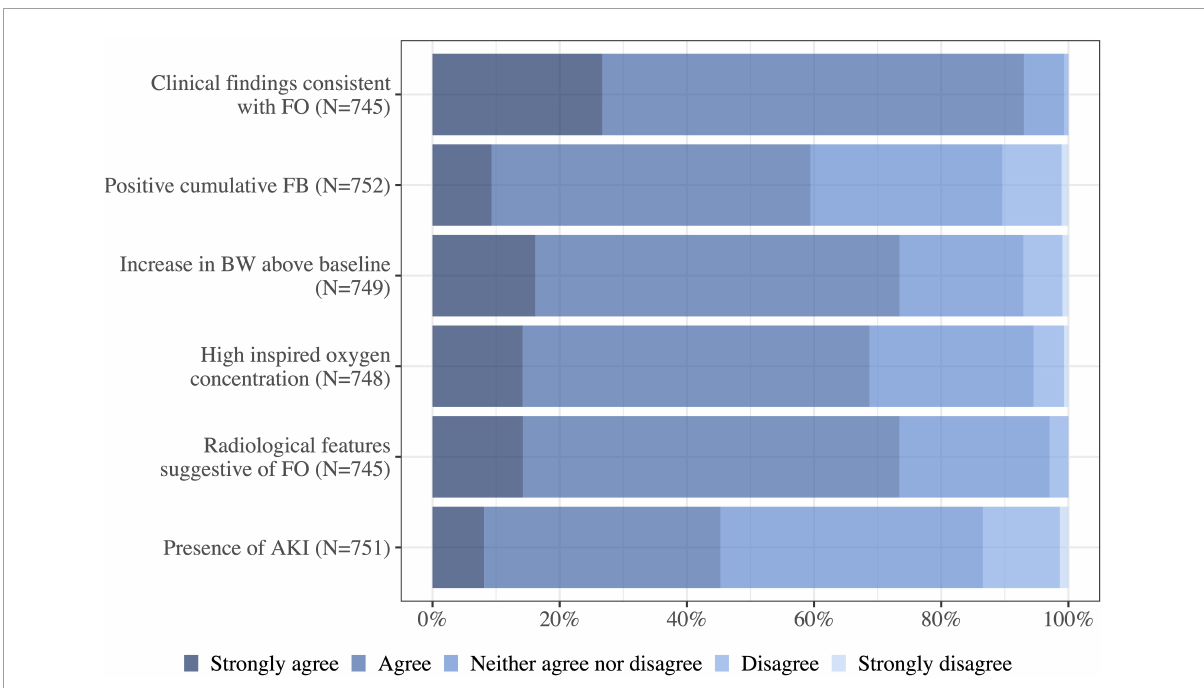
FIGURE5 How much do you agree to each of the following indications for commencing de-resuscitation in the critically ill patient without shock? FB, fluid balance; FO, fluid overload; BW, body weight; N, number of respondents to the question; AKI, acute kidney injury.